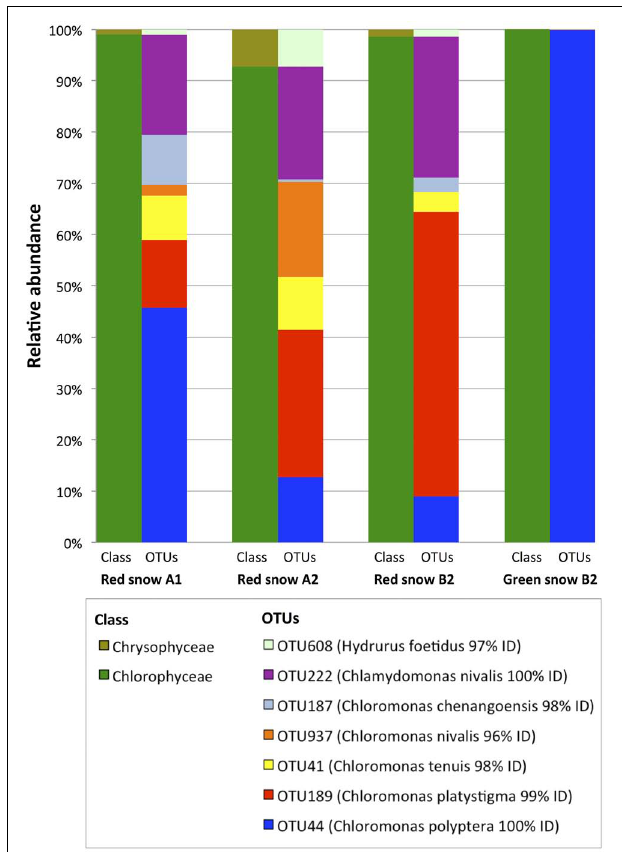
FIGURE 3 | Algal community composition based on 18S rRNA gene sequencing of three red snow samples (red snow A1, A2, and B2) and one green snow sample (green snow B2) from Mt. Asahi. Left bar represents the community composition at the class level and the right bar represents the